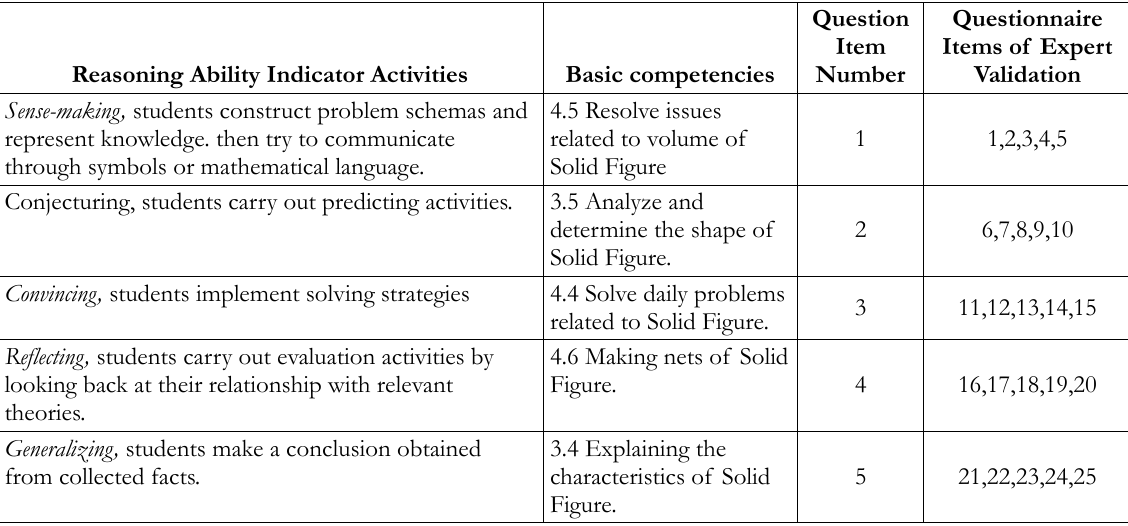
Table 3. Questionnaire Items of reasoning ability instrument